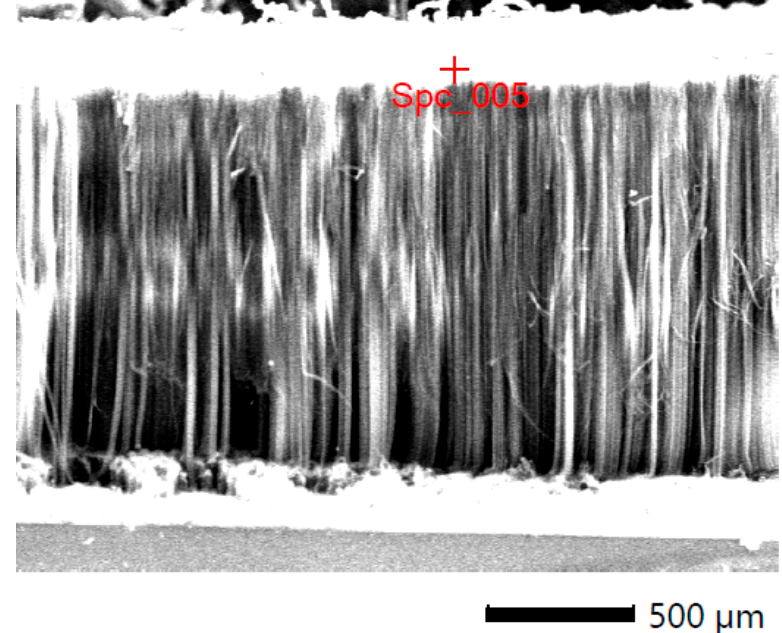
Figure 5. SEM image of ferromagnetic MWCNTs—sample with an optimum flow velocity. Side view of the aligned nanotubes.